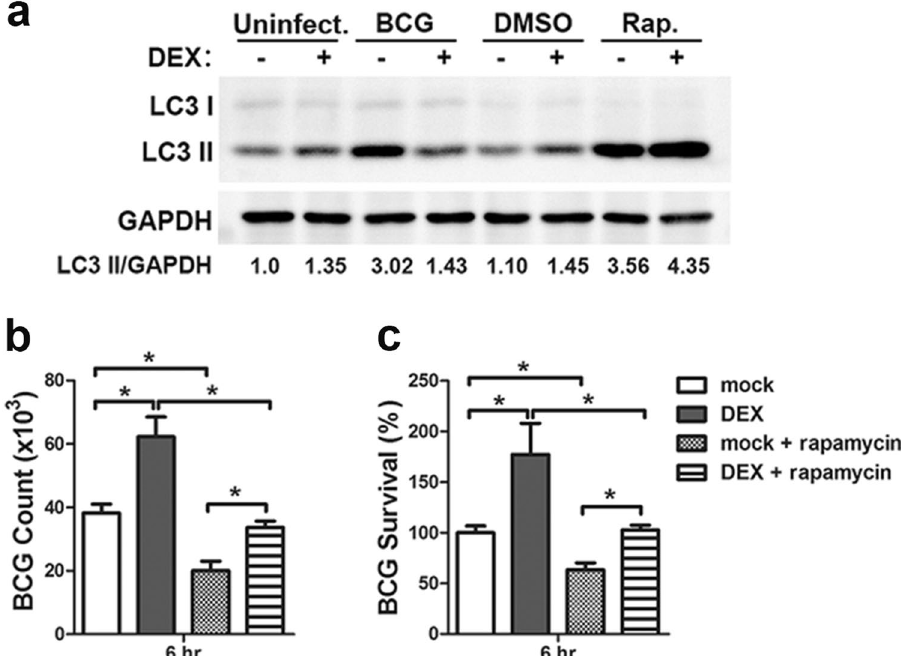
Figure 7. Glucocorticoids promote BCG survival in macrophages by inhibiting autophagy. ( a ) RAW264.7 cells were pretreated with dexamethasone (DEX) (1 μ M) or vehicle control ethanol (mock) for 6 hr and then challenged with M. bovis BCG (MOI 5) or treated with the vehicle control DMSO or rapamycin (4 μ M). LC3 level was detected with Western blot analysis. And GAPDH was used as the loading control. Full-length blots are presented in Supplementary Fig. 12. Data are representative of three independent experiments with similar results. ( b , c ) RAW264.7 cells were treated as described in ( a ), and viable bacilli were determined by CFU assays at 6 hpi ( b ). Survival rate was calculated compared with that of mock-treated cells ( c ). Data are shown as the mean ± SEM of three independent experiments. * p <